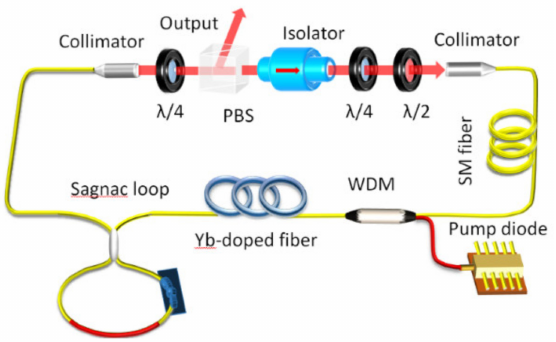
Figure 1. The configuration of an ANDi passively mode-locked Yb-doped fiber system with a Sagnac loop as the spectral filter. λ /4, λ /2: quarter and half-wave plates.